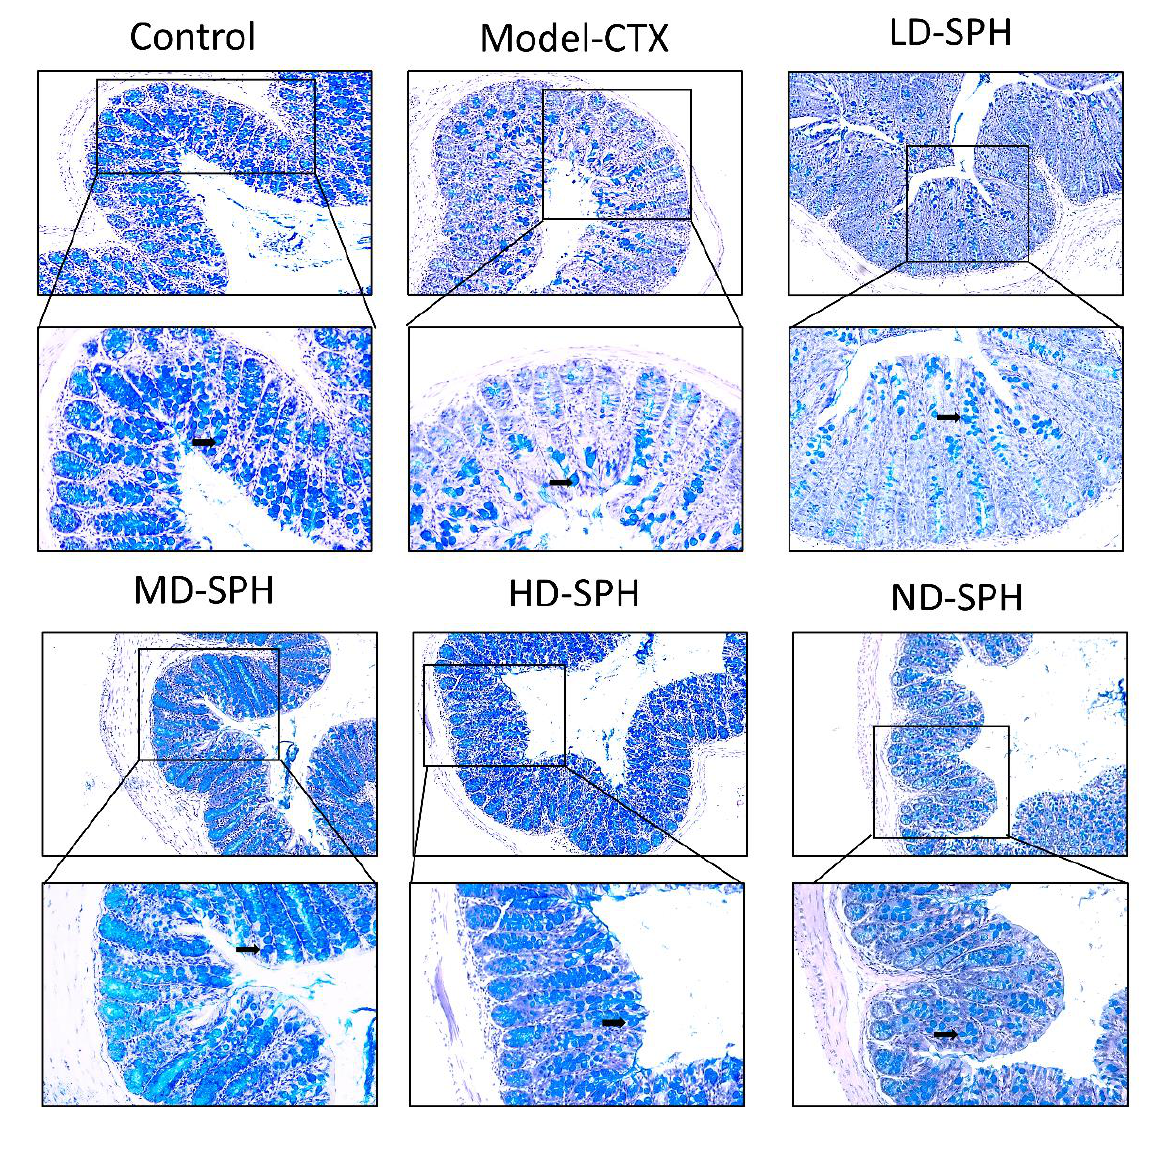
Figure 7. SPH treatment replenished goblet cells and enhanced mucin secretion in CTX-induced mice. ( a ). PAS staining ( b ). Images of colon sections are represented by AB-PAS staining. In each group, the number of goblet cells and mucin production were measured. Control mice revealed plenty of goblet cells with higher mucin expression (black arrows). In the CTX group, goblet cells were depleted completely. In SPH treated groups the number of goblet cells improved and the mucin expression is enhanced particularly at a higher dose. Magnification (upper 100×) (lower 200×).